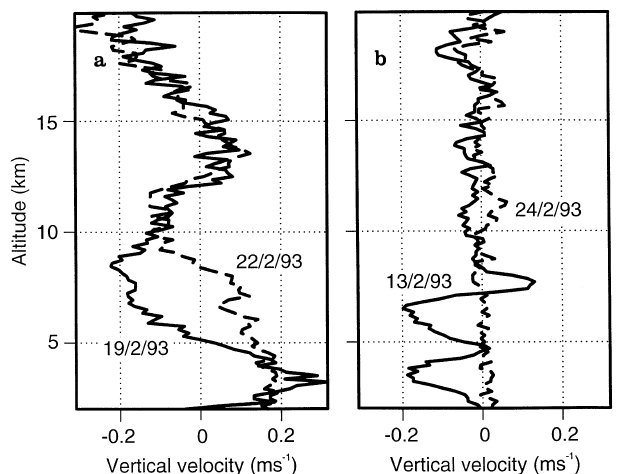
Fig. 8a, b. The mean vertical velocity profiles derived from MST radar measurements on a nights of 19 and 22 February 1993 and b nights